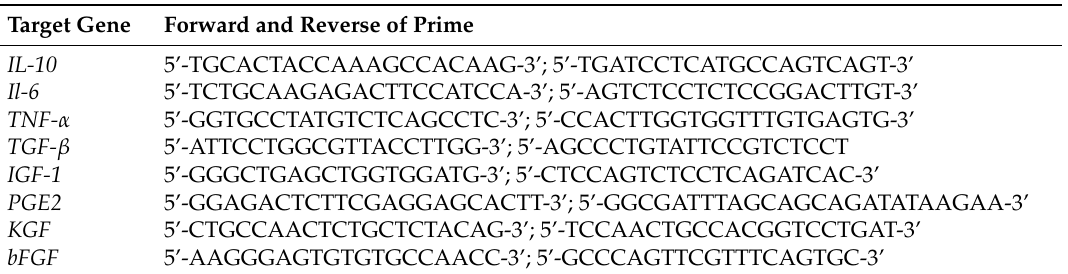
Table 1. Sequences of forward and reverse primers for target